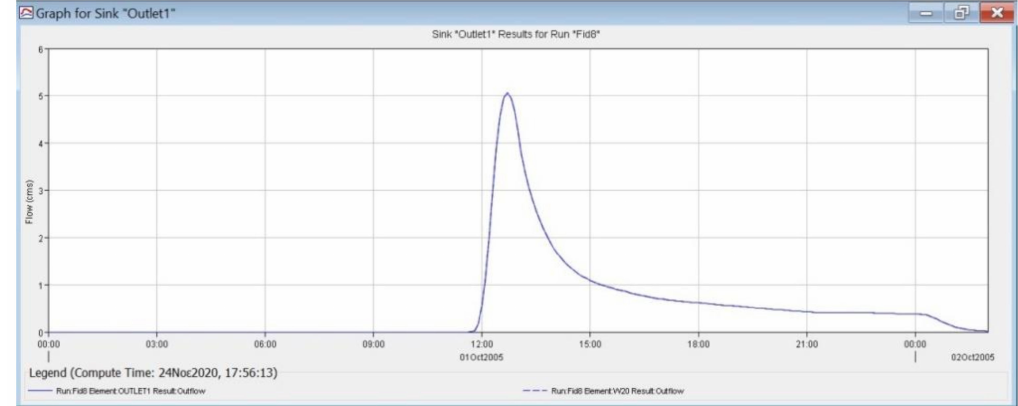
Figure 6. Simulation result for 24 h extreme storm event.